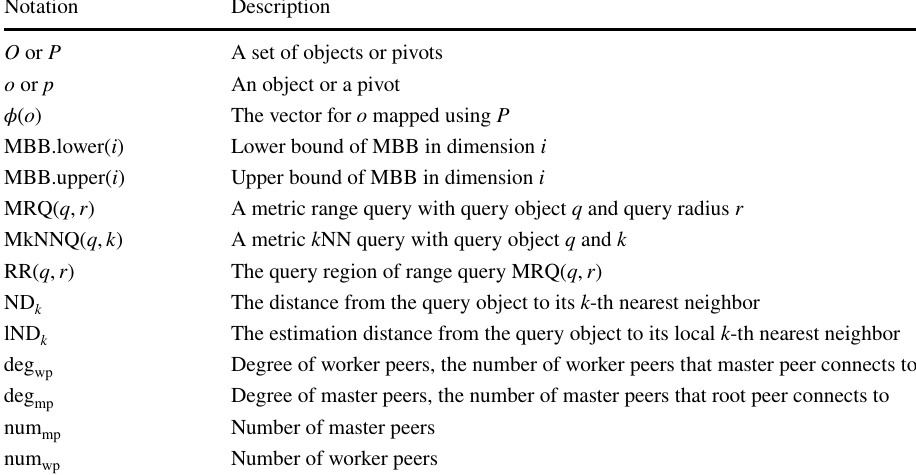
Table 1 Frequently used